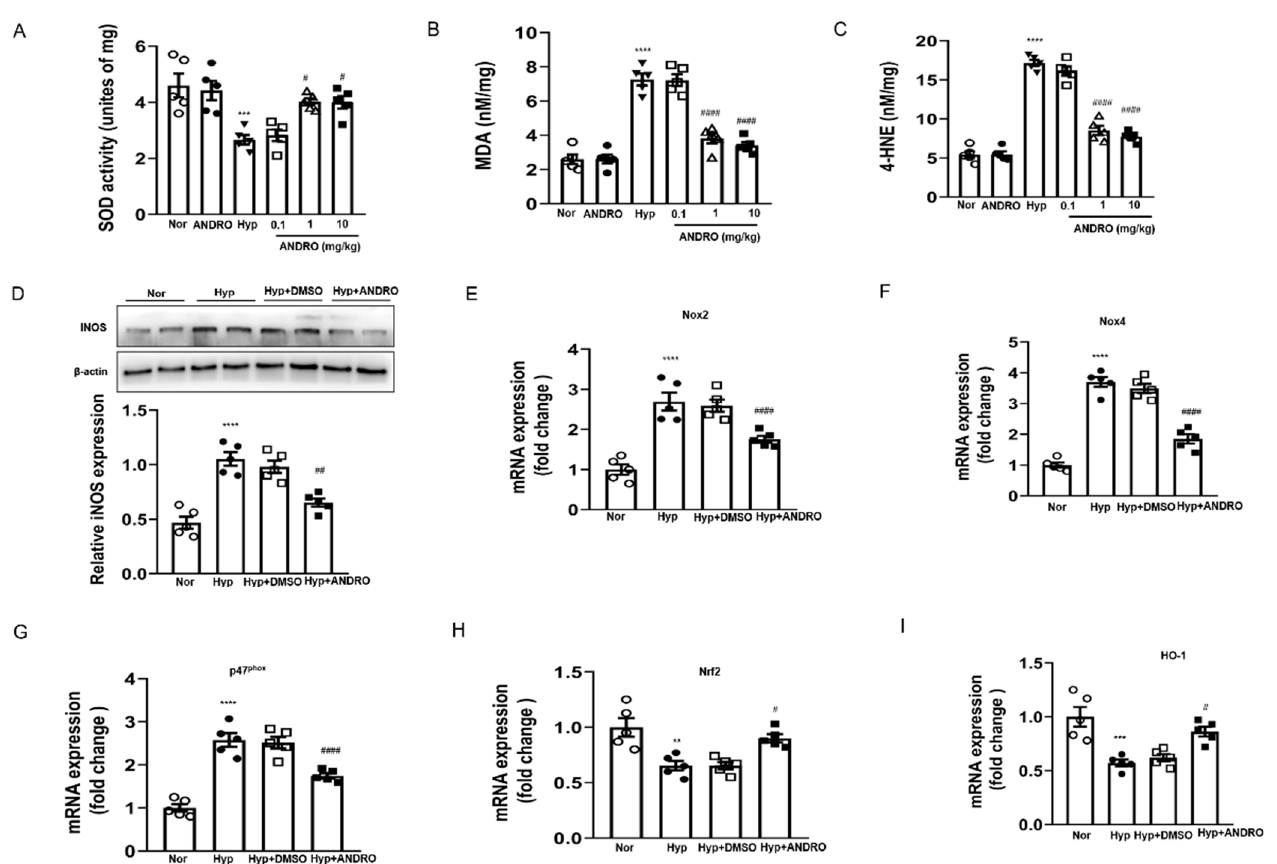
Figure 8. ANDRO treatment inhibited hypoxia-induced pulmonary oxidative/nitrative stress. ( A – C ) Effect of ANDRO on the levels of SOD ( A ), MDA ( B ), and 4-HNE ( C ) in homogenized fresh lung tissues. ( D ) Western blot analysis showing that ANDRO reversed the increased iNOS level in hypoxia-treated mice. ( E – G ) Real-time qPCR analysis showing that ANDRO treatment reduced hypoxia-upregulated mRNA expression of the ROS-generating NADPH oxidases (NOX2, NOX4, and p47 phox) in the lung tissues. ( H , I ) Real-time qPCR analysis showing that the down-regulated mRNA expressions of Nrf2 and HO-1 in the lung tissues were attenuated by ANDRO treatment. ** p < 0.01, *** p < 0.001, **** p < 0.0001, compared to normoxia control; # p < 0.05, ## p < 0.01, #### p < 0.001, compared to Hyp-DMSO.